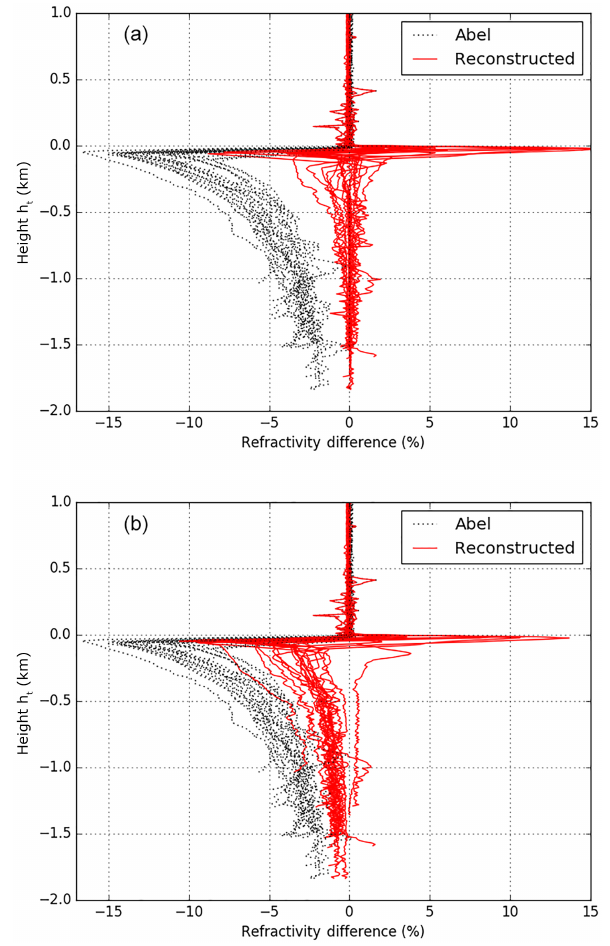
Figure 6. The refractivity differences between the RAOB profiles, the Abel-retrieved profiles, and the reconstructed profiles for the 19 simulation cases with the single ducting layer in the VOCALS campaign using the PW from RAOB (a) and ECMWF (b) . While the proposed method can correct the N -bias using both RAOB and ECMWF PW, the reconstructed profiles show higher variance and are slightly biased below the trapping layer with ECMWF PW.